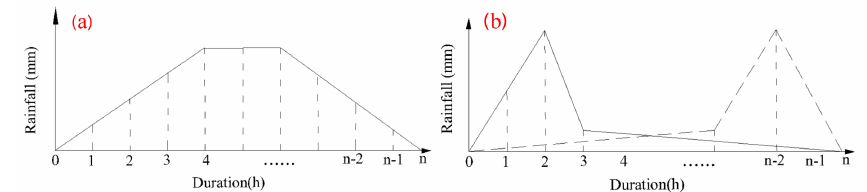
Figure 9. The diagram of rainfall patterns.